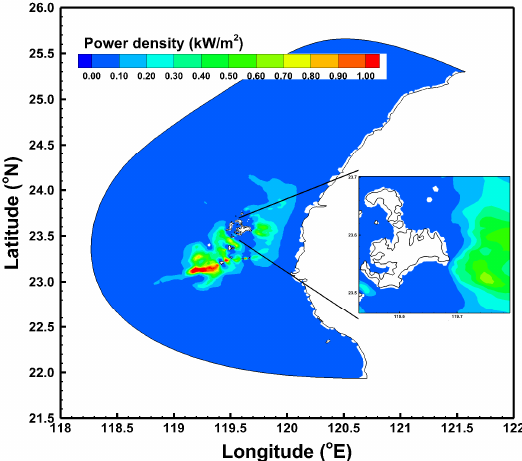
Figure 7. Mean power density distribution around Taiwan Strait.